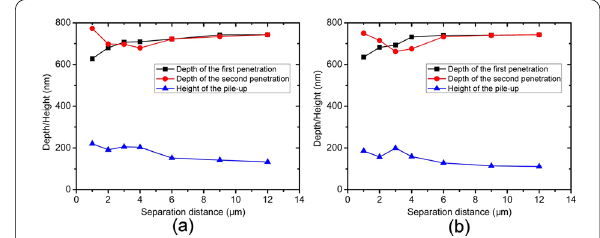
Figure 7 Indentation depth and pile-up height of the two adjacent indentations with the rotation angles of a 0° and b